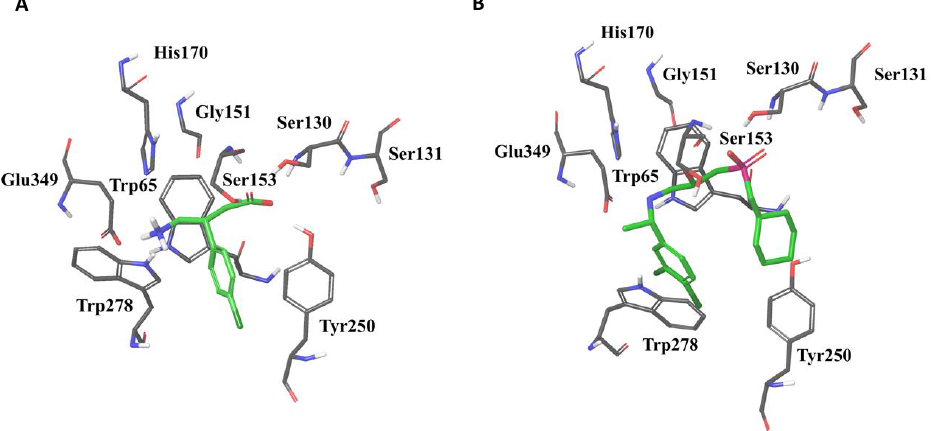
Figure 3. The agonist baclofen ( A ) and the antagonist CGP54626 ( B ) in the GABA B1b VFT binding pocket surrounded with residues important for ligand binding (PDB ID: 4MS4 and 4MR7, respectively). Trp278 and Tyr250 are located in Lobe 2 of the GABA B1 VFT, whereas the remaining residues are located in Lobe 1.